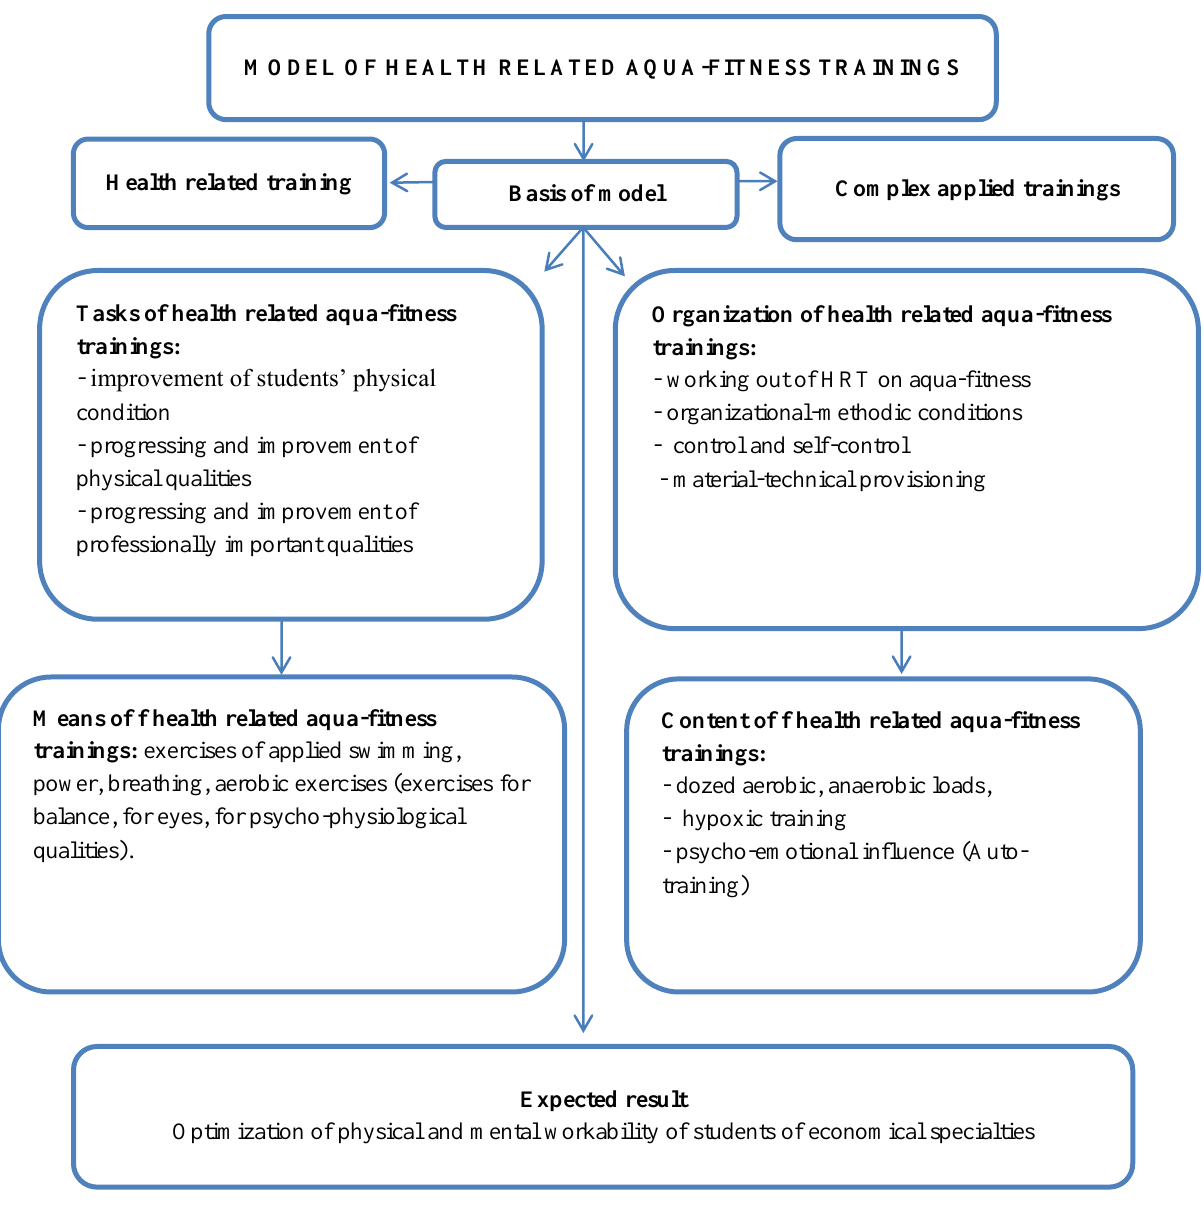
Fig.1. Structural-logic diagram of model of health related aqua-fitness